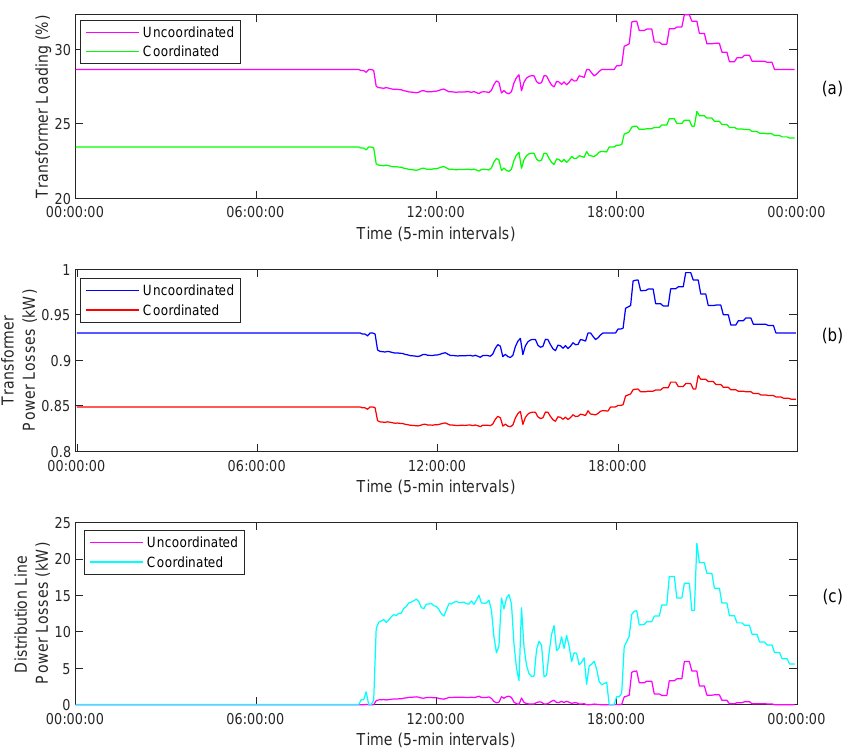
Figure 12. Transformer loading ( a ), transformer losses ( b ) and distribution line losses ( c ) for uncoor- dinated vs. proposed DCC methods with PV and BES